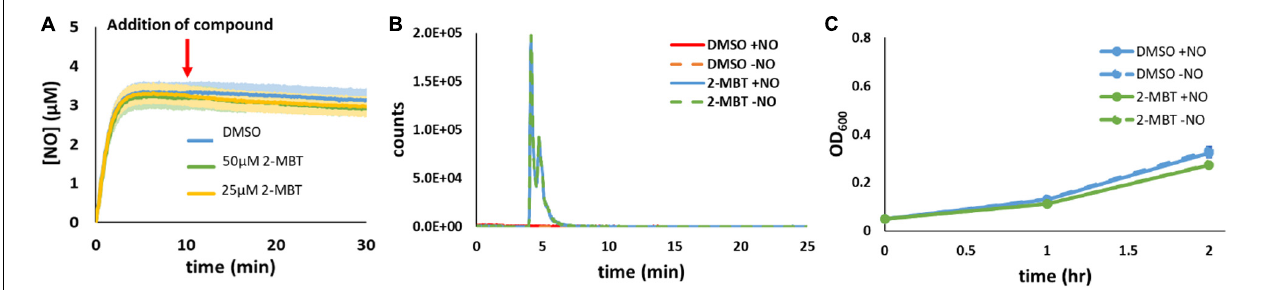
FIGURE 4 | Reactivity of 2-MBT to NO in the absence of cells. (A) [NO] in the bioreactor in the absence of cells was measured. At t = 0, DPTA was added and after 10 min different concentrations of 2-MBT or the same volume of DMSO was added to the bioreactor. The solid lines represent the averages from at least 3 biological replicates, and the shaded regions represent the standard errors of the means. (B) 34 µ M of PAPA or 34.7 µ L of 10 mM NaOH were added to a bioreactor containing MOPS and 50 µ M of 2-MBT or DMSO in the absence of bacteria. After 2 h, which correspond to the amount of time it took for NO to deplete under cell-free settings ( Supplementary Figure S1 ), samples from the bioreactor were withdrawn for LC-MS analysis. Representative extracted-ion chromatograms (EIC) at m/z of 167.9 of 3 replicate experiments are plotted. Representative total-ion current chromatogram (TIC) is provided in Supplementary Figure S5 and no significant signal intensities for the 2-MBT dimer or other oxidized species were observed in the mass spectra. (C) Bacterial growth in the bioreactor containing MOPS and 2-MBT or DMSO that had or had not been exposed to NO was measured hourly. The solid dots represent the average OD 600 from 3 biological replicates, and the error bars the error of the